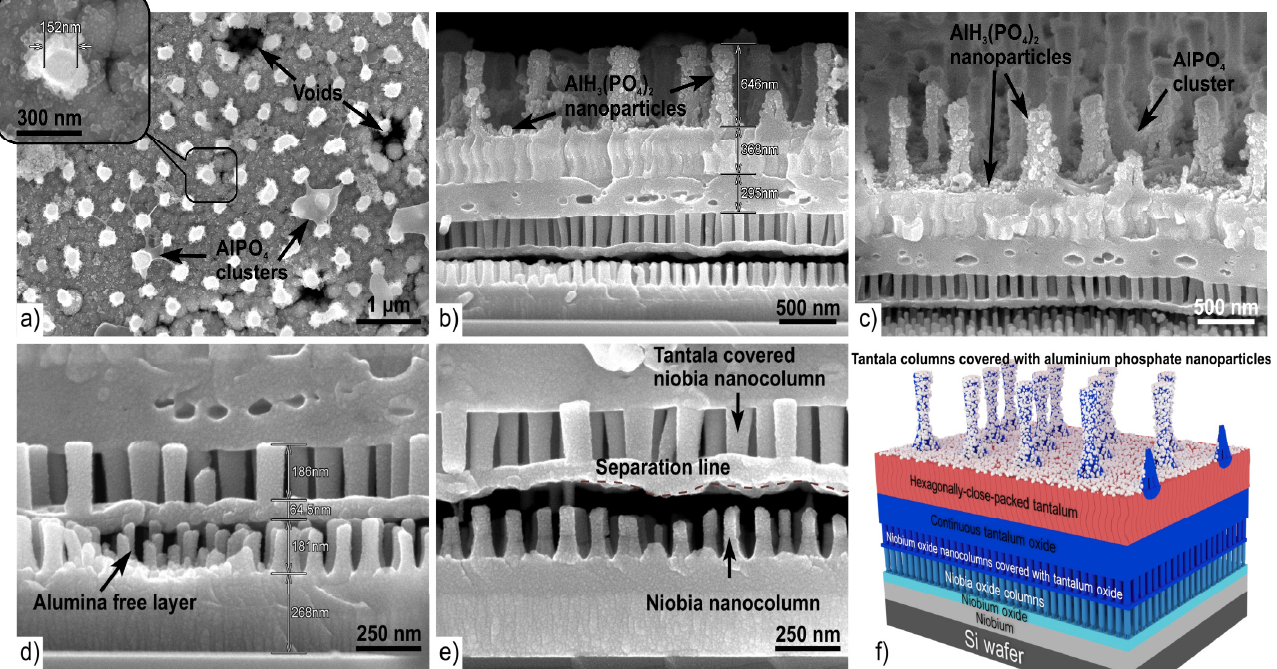
Figure 7. SEM surface ( a ), cross-fractured ( b – e ) and 3D schematic views ( f ) of the anodic two-level column-like 3D nanofilm with hexagonally close-packed tantalum after 24 h long cold (23 °C) chemical etching in 50% aqueous orthophosphoric acid.